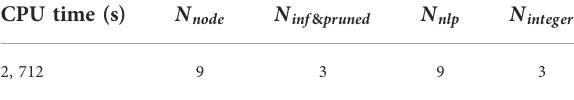
TABLE 3 Computational performance for Example 1. TABLE 4 Feed conditions for Example